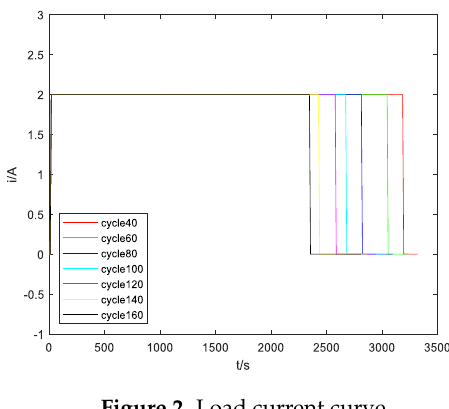
Figure 2. Load current curve.